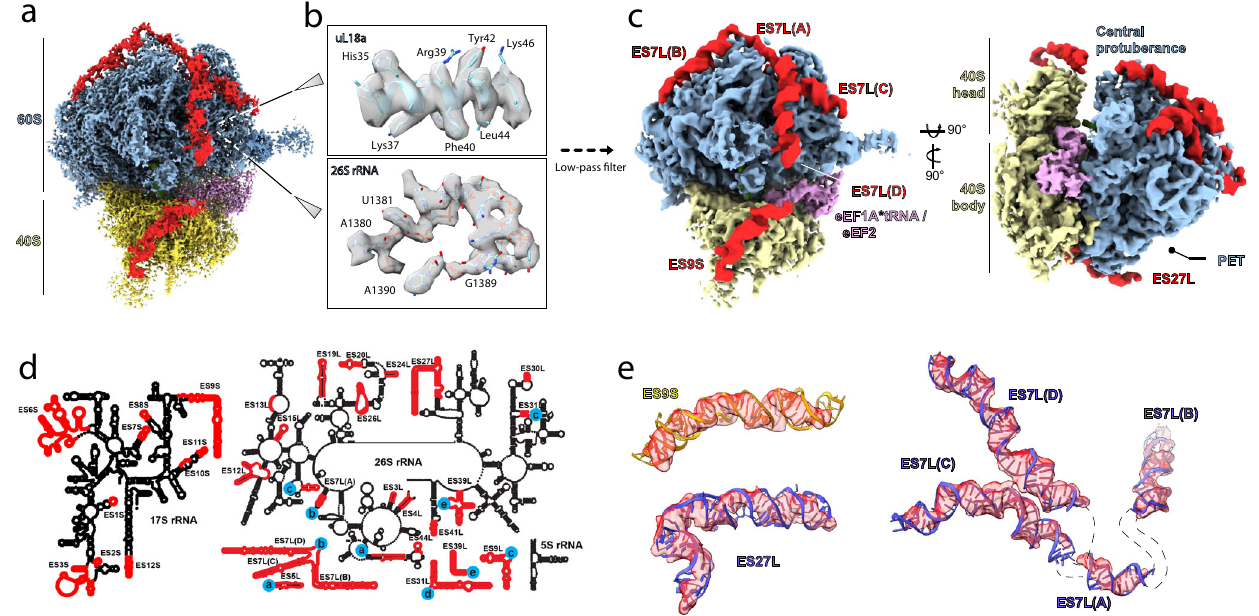
Fig. 2 | Visualization of the expansion segments on the 80S ribosome. a 3.8Å structureof80Sribosomesubtomogramaverage.Expansionsegmentsarecolored in red, the density corresponding to the A/T-tRNA, eEF1A, and eEF2 in lavender. b Close-up view of the density in the 60S core of protein uL18a and a fragment of 26S rRNA with fi tted models. c Gaussian- fi ltered (sDev=2) 80S ribosome density mapshowingthecloseproximitybetweenES9SandES7L(D),andtheprotrusionof